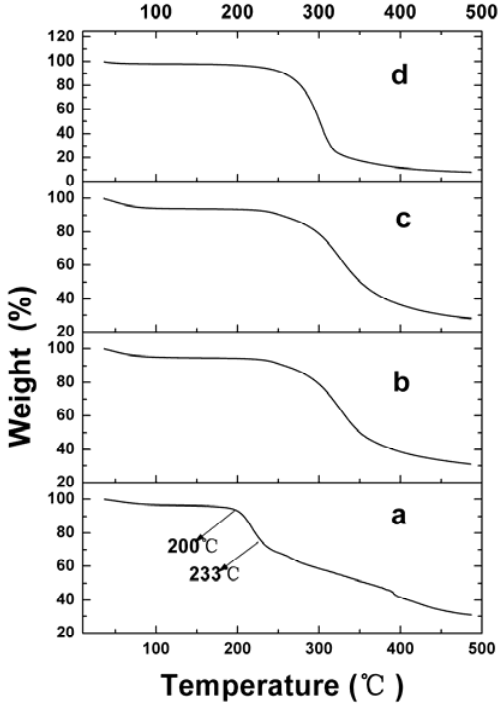
Figure 7. Thermogravimetric analyzer (TGA) results of raw VLBT and VLBT-loaded nanoparticles. ( a ) Raw VLBT; ( b ) VLBT-BSANPs; ( c ) Fa-BSANPs-VLBT; ( d ) Fa-BSANPs-VLBT with